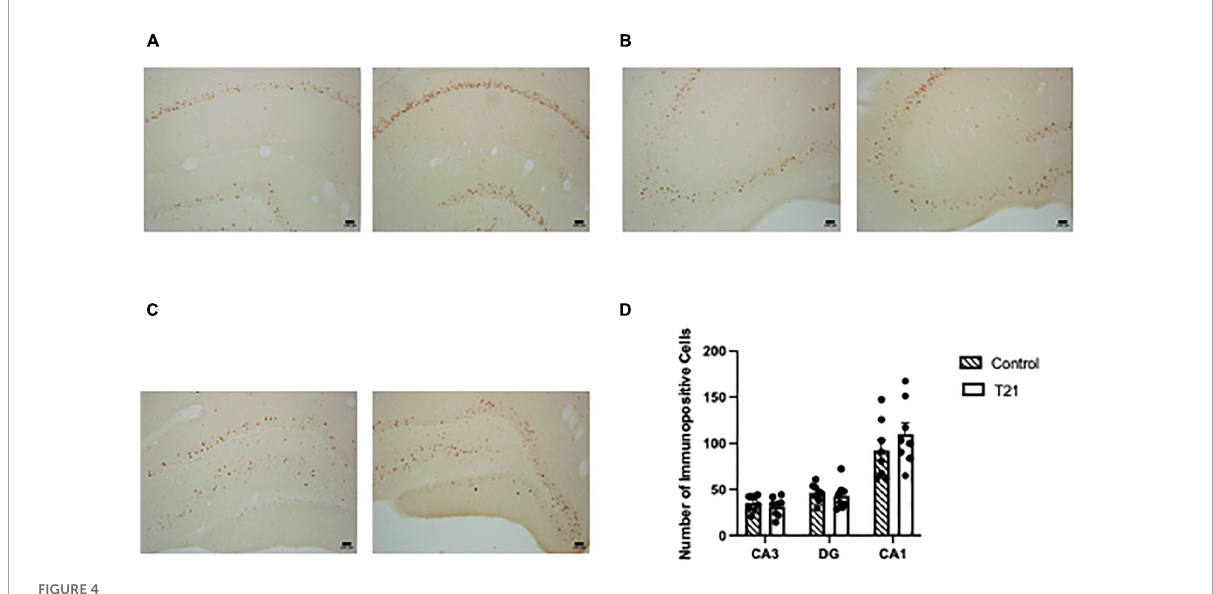
FIGURE4 Hippocampal c-FOS expression. The left picture in each figure was taken from a control rat and the right picture in each figure was taken from a T21 rat. For all subregions the pictures were taken from the same control and T21 animal. (A) c-FOS expression in CA1. (B) c-FOS expression in CA3. (C) c-FOS expression in the dentate gyrus. (D) Average ( ± SEM) number of c-FOS+ cells in each subregion of the dorsal hippocampus between